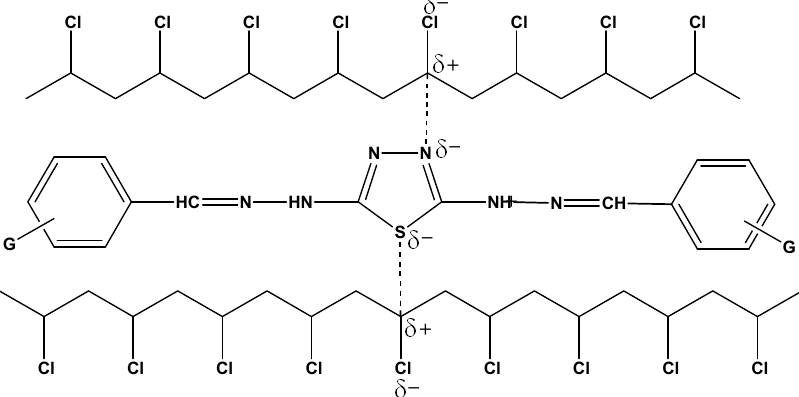
Scheme 5. The suggested mechanism of the photostabilization of 2,5-di(arylhydrazones)-1,3,4- thiadiazole compounds through the interaction between PVC and Schiff base compounds. The hydroxyl group of the additive might act as a radical scavenger for the photostabilization process. Therefore, these Schiff bases, besides acting as UV absorbers, may also act as radical scavenger additives, as shown in Scheme 6.